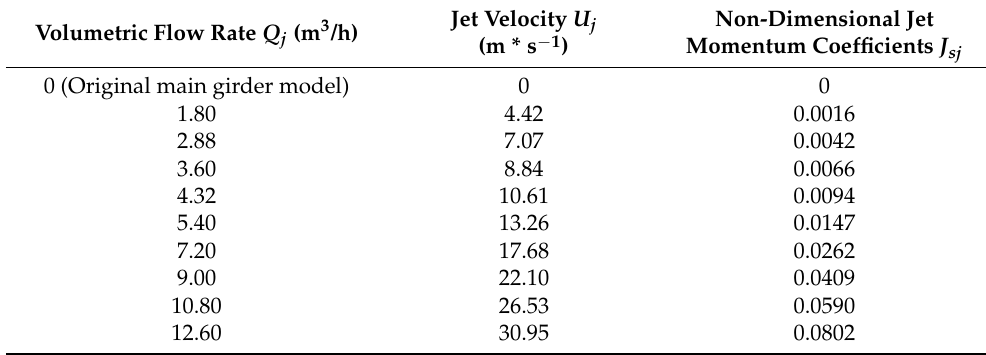
Table 1. J sj for the SBG model with different jet rates.